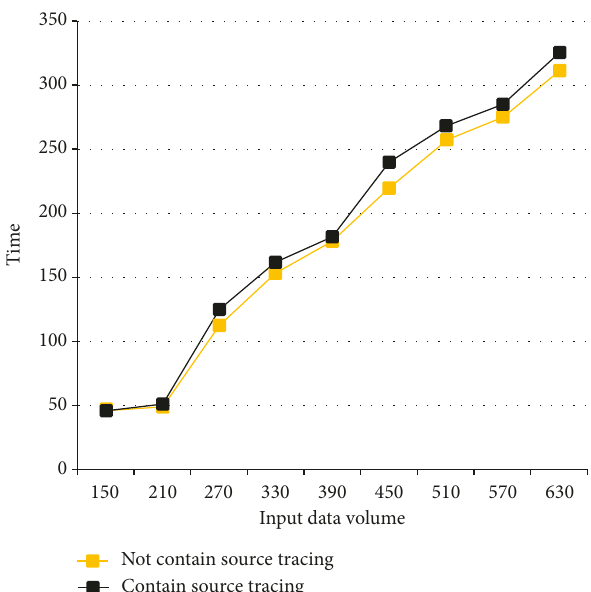
Figure 6: Execution time of the map phase of big data analysis.